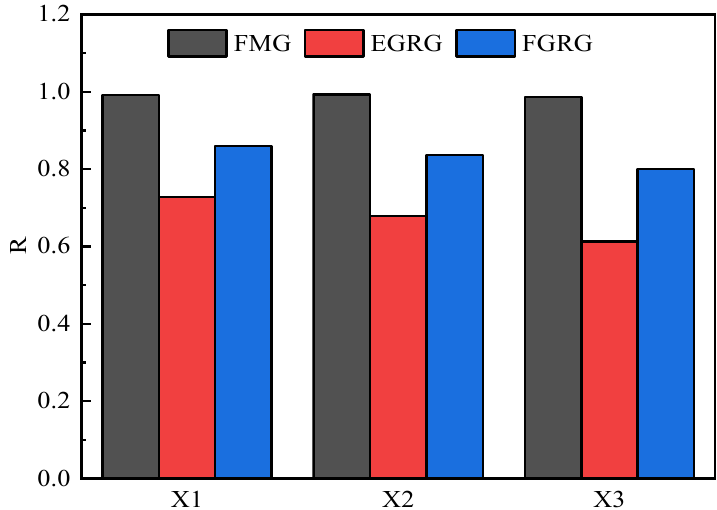
Figure 17. The influence of three structural factors on outflow.